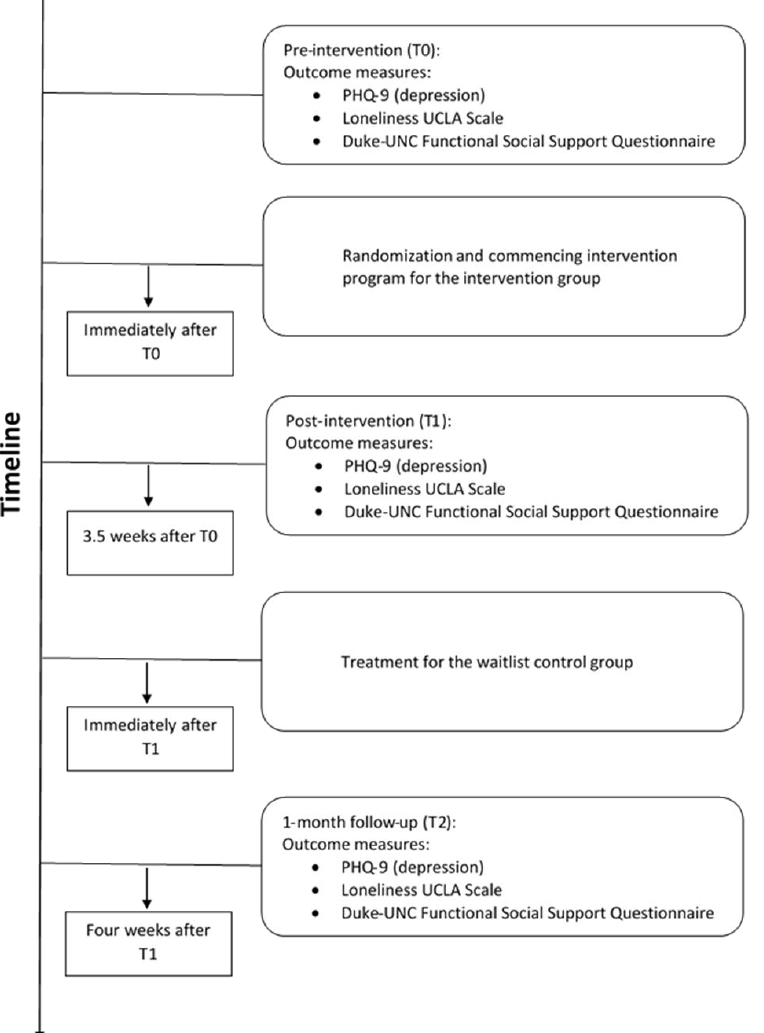
Figure 1. Timeline for the intervention and measurement